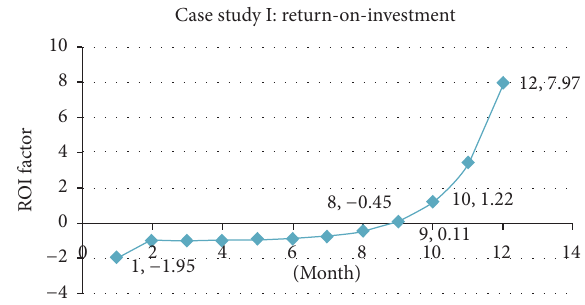
Figure 4: Graphical representation of ROI for Table 13.